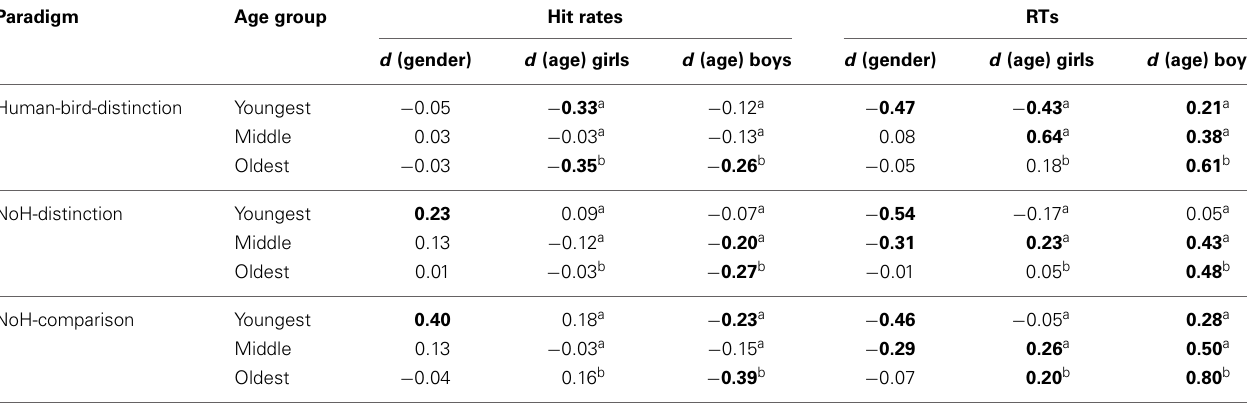
a Comparing row’s mean to oldest age group. b Comparing row’s mean to youngest age group.